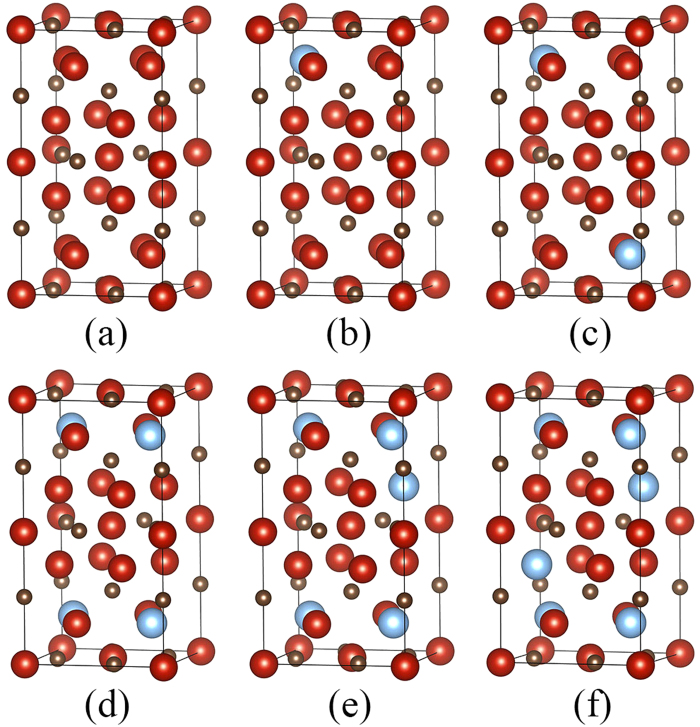
The supercells of (a) V5C3, (b) (V0.95Ti0.05)5C3, (c) (V0.9Ti0.1)5C3, (d) (V0.8Ti0.2)5C3, (e) (V0.75Ti0.25)5C3 and (f) (V0.7Ti03)5C3.